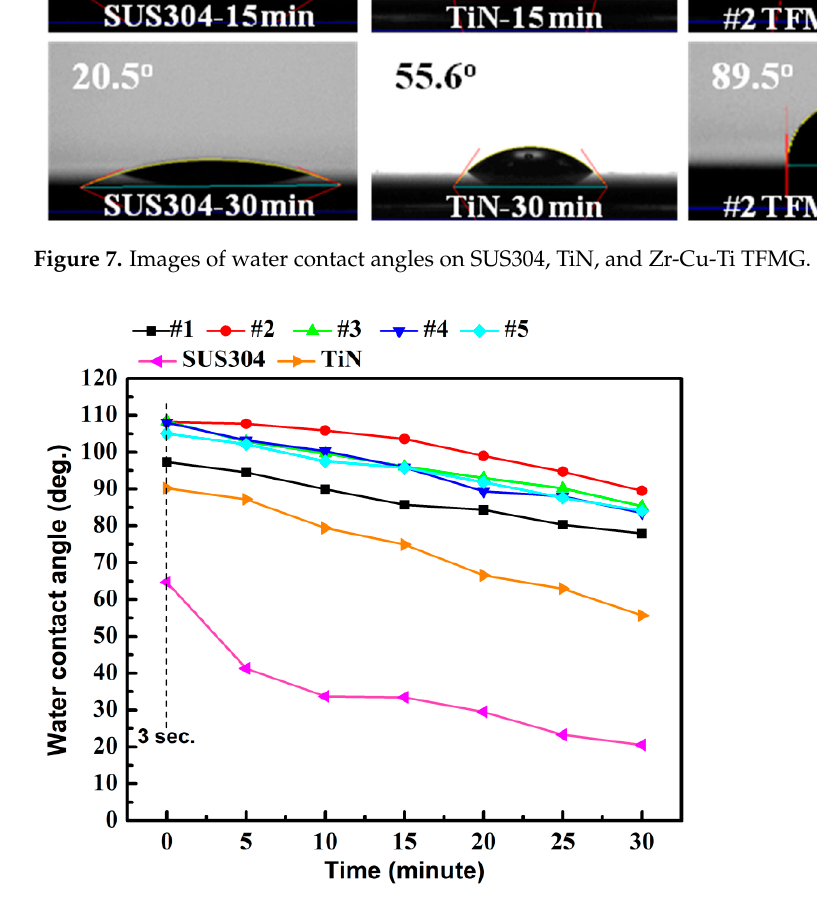
Figure 8. Evolution of contact angle as a function of exposure time under ambient conditions where initial measurements were completed within 3 s.